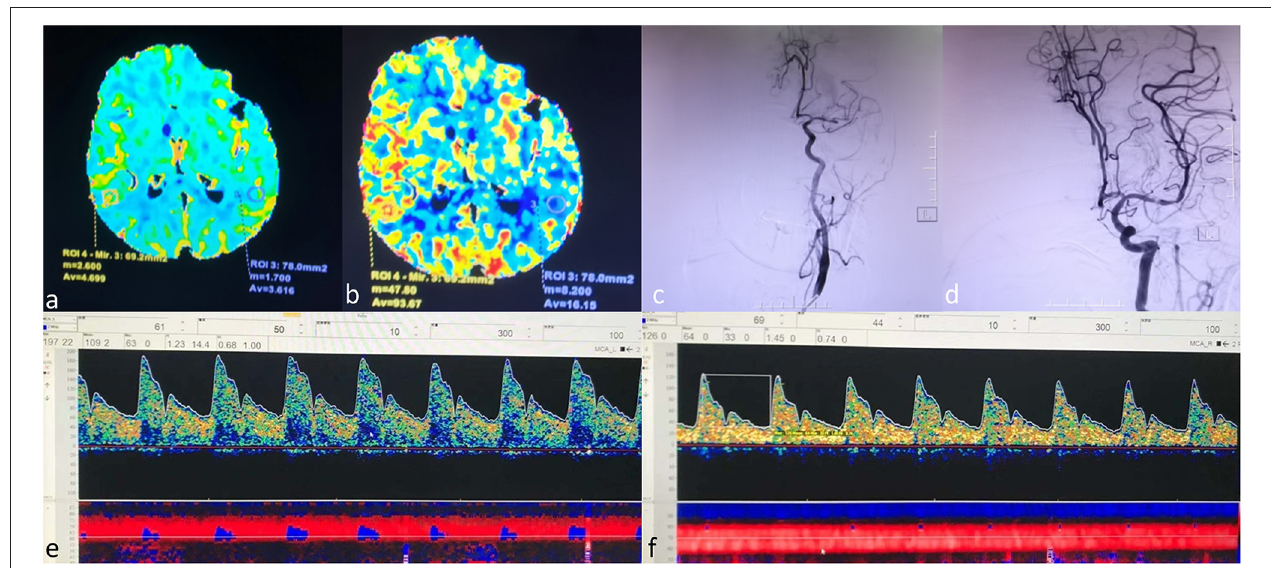
FIGURE 1 | A case example. An 80-year-old female who received a successful mechanical thrombectomy in the left middle cerebral artery (MCA) branch M1. The CTP series showed that CBV did not increase (a) . Mildly increased CBF (b) . The left MCA occluded entirely on DSA before EVT (c) . The left MCA reappeared entirely on DSA after EVT (d) . The PSV of the left MCA was 197 cm/s, and MFV increased higher than 125% compared to that on the right side [ (e) , left MCA; (f) , right MCA]. The patient was given nicardipine until the flow velocity of the left MCA was restored to the normal. The patient had no hemorrhagic transformation and achieved an mRS score of 0 at 90 days. MCA = middle cerebral artery, CTP = computed tomography perfusion, CBV = cerebral blood volume, CBF, cerebral blood flow, DSA, digital subtraction angiography, EVT, endovascular thrombectomy, PSV, peak systolic velocity, MFV, mean flow